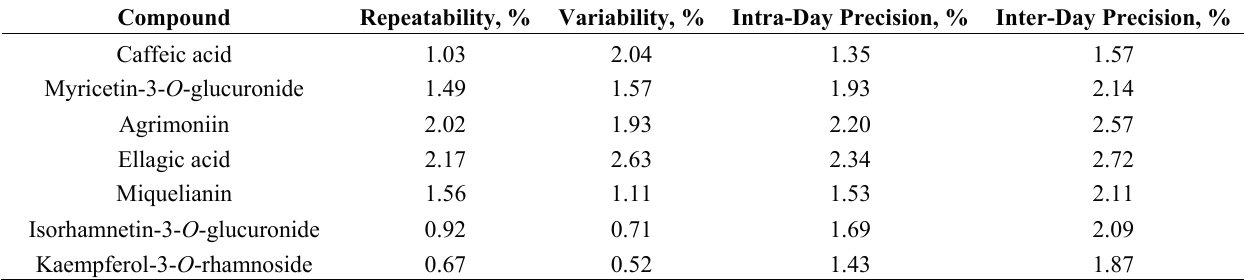
Table 3. Precision and repeatability data of seven compounds from P. anserina . Compound Repeatability, % Variability,